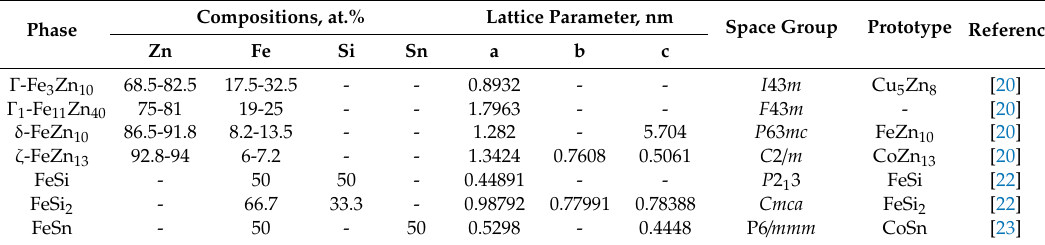
Space Group Space Group Prototype Reference